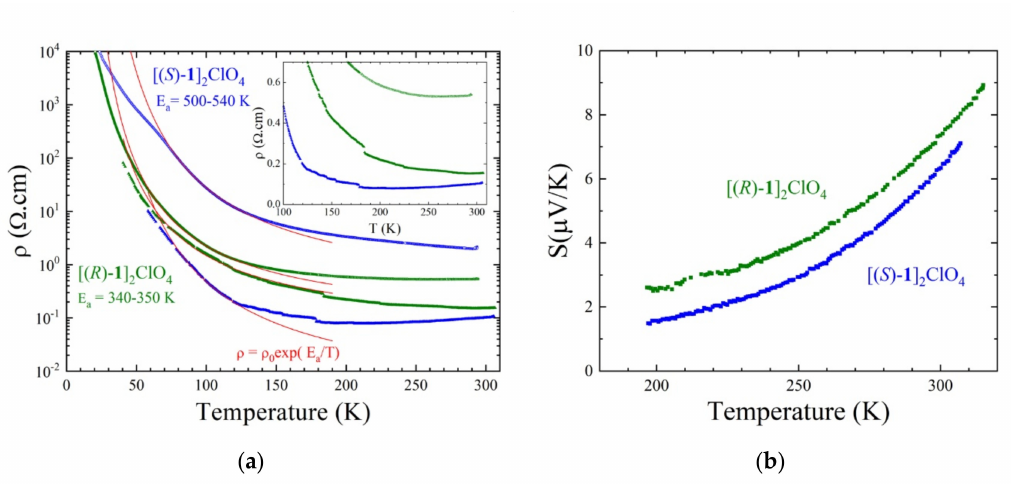
Figure 5. ( a ) Temperature dependence of the electrical resistivity ρ for single crystals of [( S )- 1 ] 2 ClO 4 (blue curves) and [( R )- 1 ] 2 ClO 4 (green curves) measured using either four in-line contacts (two lower curves, full symbols) or two contacts (two upper curves, empty symbols). The red lines are the fit to the activation law ρ = ρ 0 exp(E a / T) in the 80–130 K temperature range. The inset shows the same resistivity data on a linear scale in order to emphasize the high temperature conducting regime in the three lower curves. ( b ) Temperature dependence of the thermoelectric power for a single crystal of [( S )- 1 ] 2 ClO 4 (blue curve) and [( R )- 1 ] 2 ClO 4 (green curve).